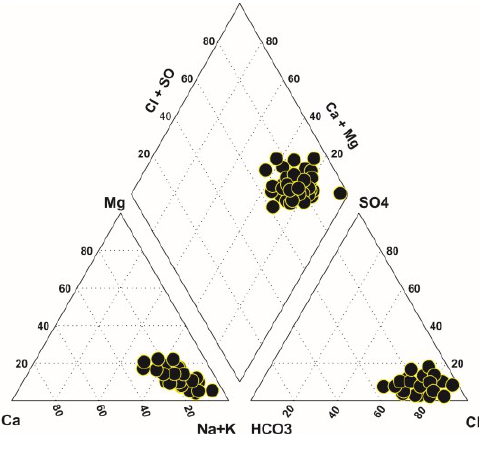
Figure 2. Piper plot shows hydrochemical facies in the study